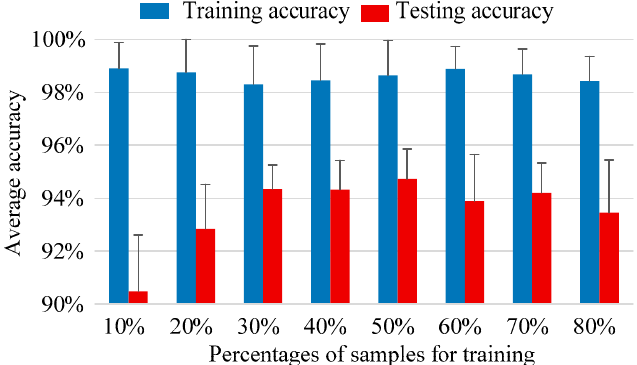
Figure 21. The classification results of the proposed method using training by di ff erent percentages of samples.